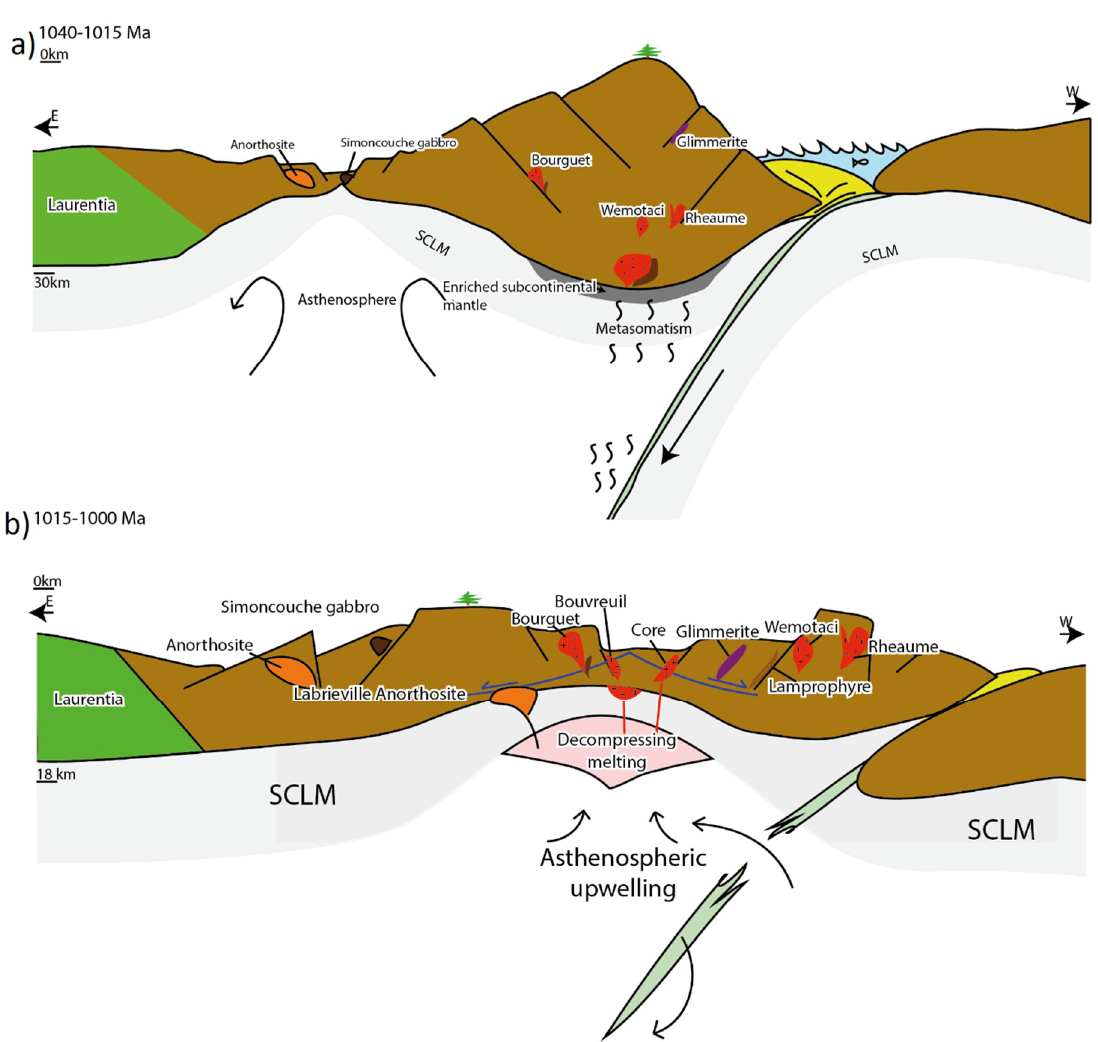
Figure 7. Geological model for events between 1040–1015 and 1015–1000 Ma, ( a ) shows a magmatic event associate with a volcanic arc, ( b ) shows an alkali magmatic event associated with an orogenic collapse (Simoncouche gabbro [34], Labrieville Anorthosite [35], Lamprophyre [36]).